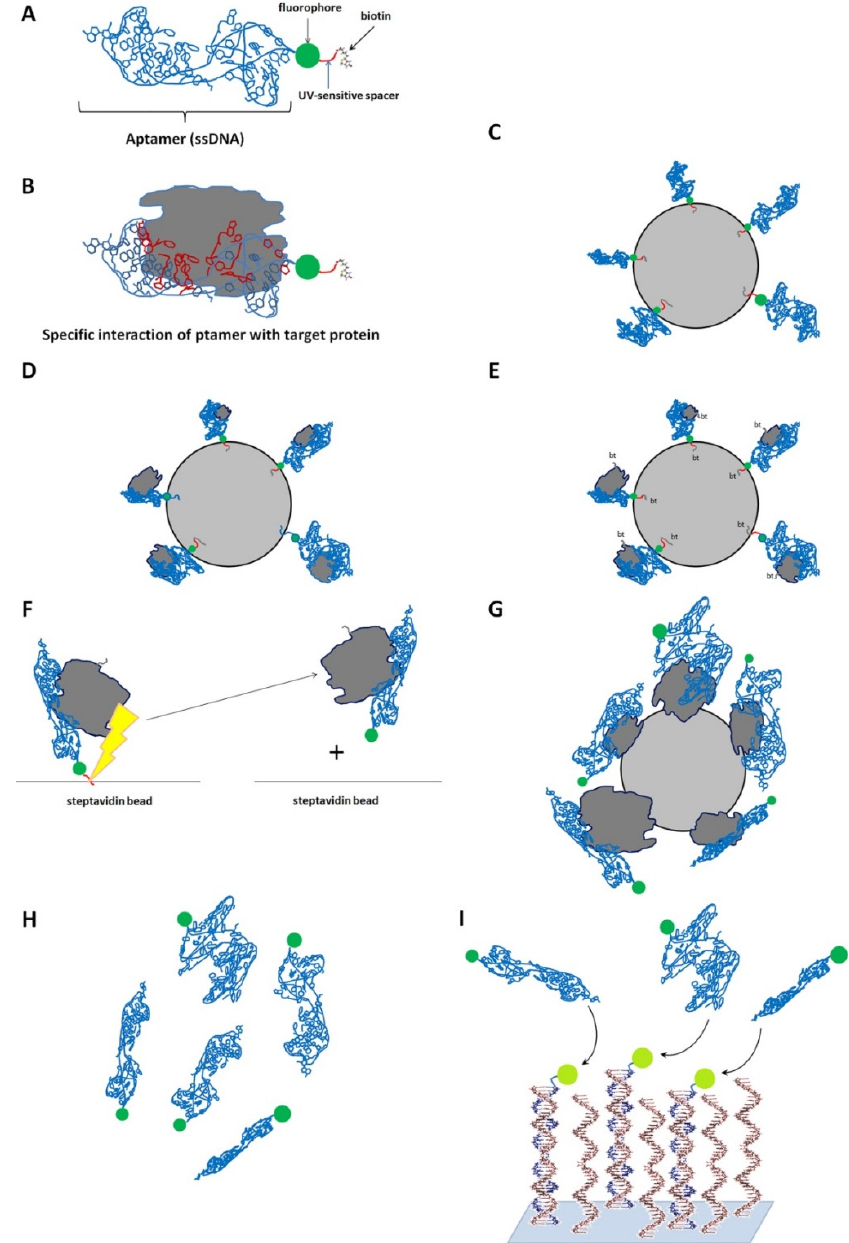
Figure 5. The principle of the SOMAscan. ( A ). Aptamers used in the study interact with a specific protein (target). Each aptamer contains three parts: a single-stranded DNA made of both canonical and modified deoxyribonucleotides (light blue), fluorophore (green), a UV-sensitive spacer (red), and biotin (grey). ( B ). The specific interaction of an aptamer with a target protein. The nucleotides directly interacting with a protein are shown in red and the others—in dark blue. A SOMAscan includes several steps. ( C ). Incubation of aptamers with streptavidin beads (Step 1). Because the aptamers contain biotin, they bind to the beads via biotin. ( D ). Incubation of streptavidin-coupled aptamers with the desired protein sample (Step 2). As protein samples used in the experiment presumably contain target proteins, aptamers specifically interact with their target protein in the 1:1 ratio. ( E ). Biotinylation of the target proteins with biotin, bt (Step 3). ( F ). Photosensitive cleavage of the spacers from aptamers followed by a separation of aptamers from the beads (Step 4). ( G ). The released complexes of aptamers and biotinylated proteins become recaptured by streptavidin beads (Step 5). As target proteins are biotinylated, they interact with streptavidin beads via biotin. ( H ). Dissociation of aptamers from their target proteins (Step 6). ( I ). Hybridization of aptamers with the probes